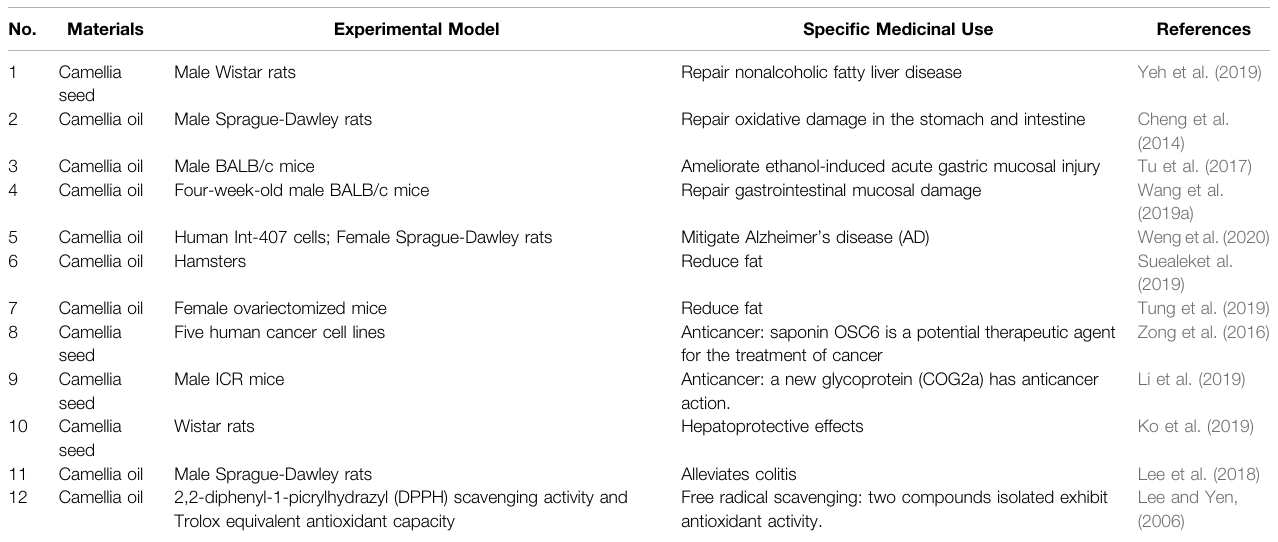
TABLE 2 | Speci fi c medicinal uses of camellia